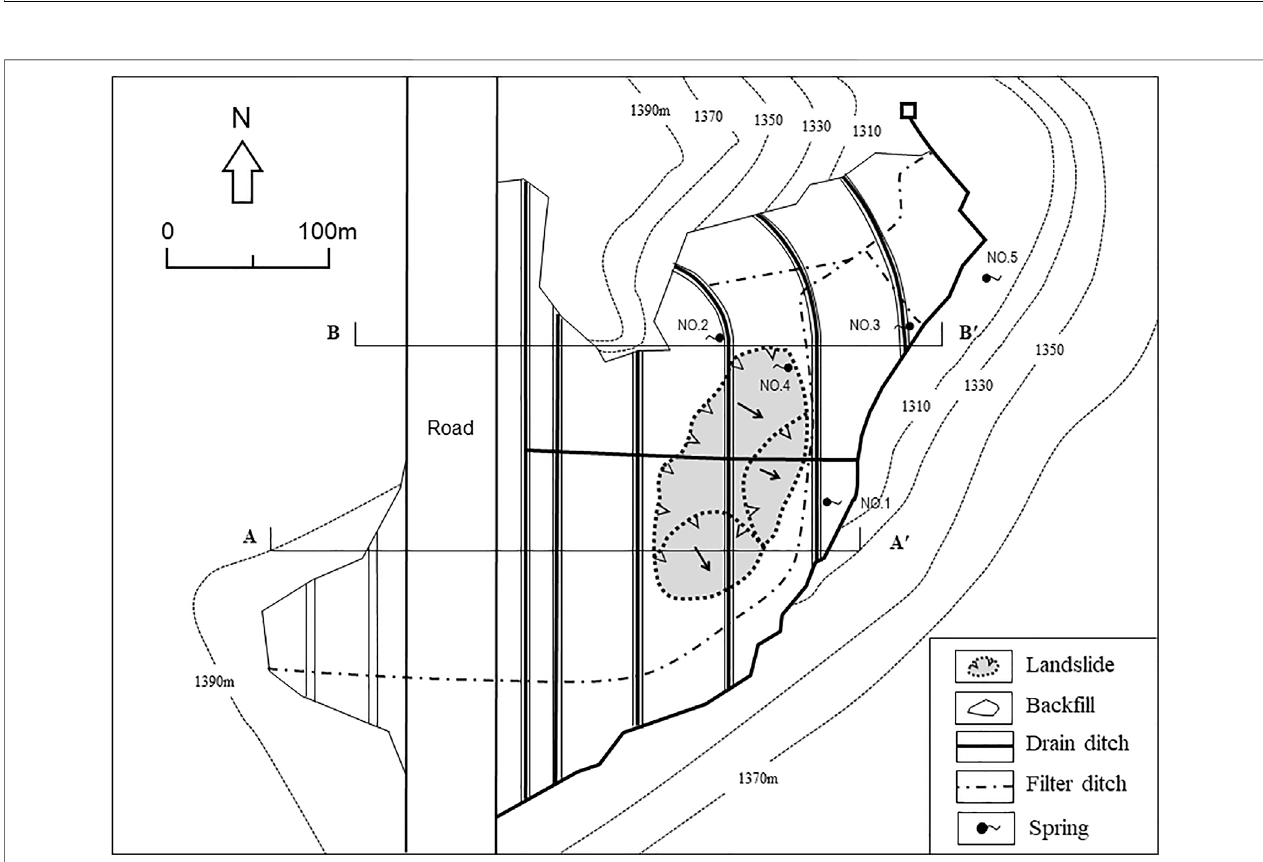
FIGURE 7 | Layout of the back fi lled high embankment. A — A ’ and B — B ’ are section lines.